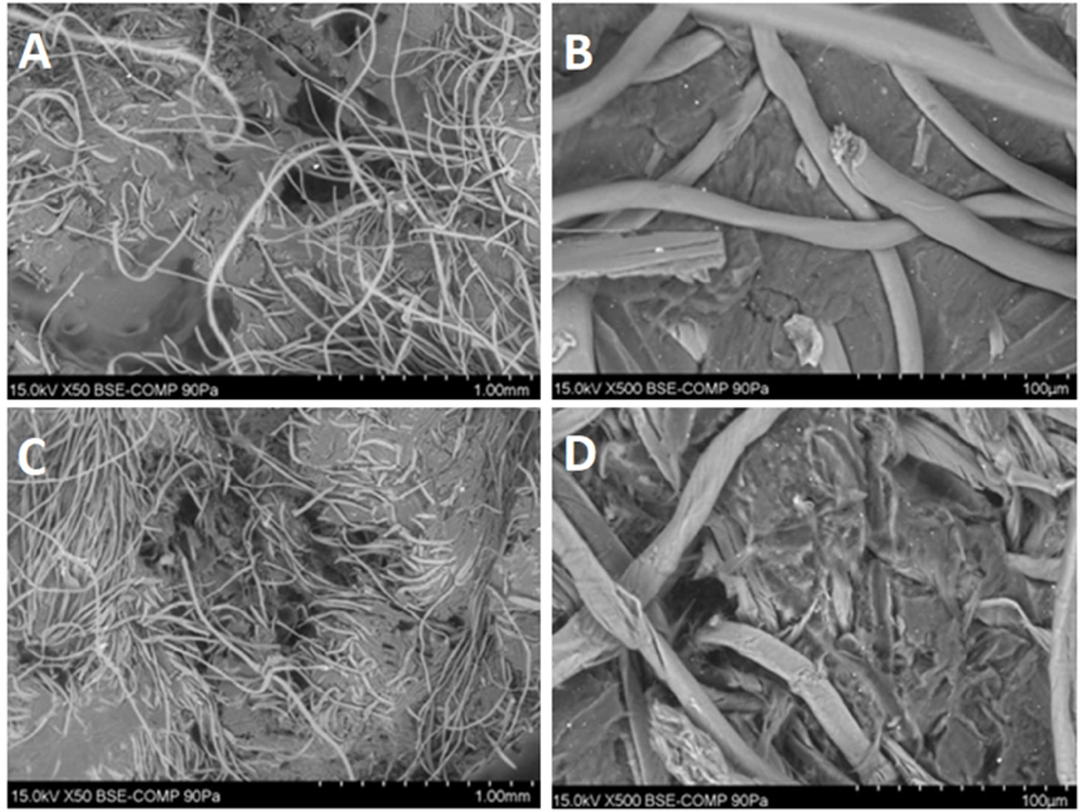
Figure 2. SEM images of the studied materials at a magnification of 50× and 500×. Images at top ( A , B ) are images for the PET sample, and images at bottom ( C , D ) are images for the rayon samples. Images in the left column ( A , C ) are magnification of 50×, and images in the right column ( B , D ) are magnification of 500×.